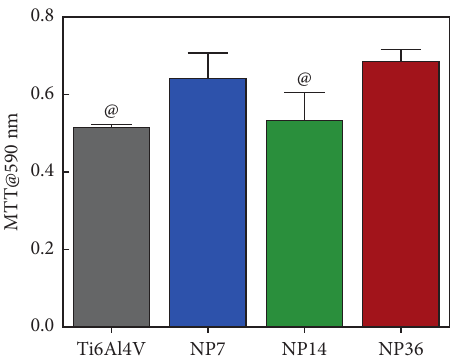
Figure 6: Osteoblast viability assessment after 24h on the ex- perimental materials. The symbol @ indicates statistical differences against NP7 and